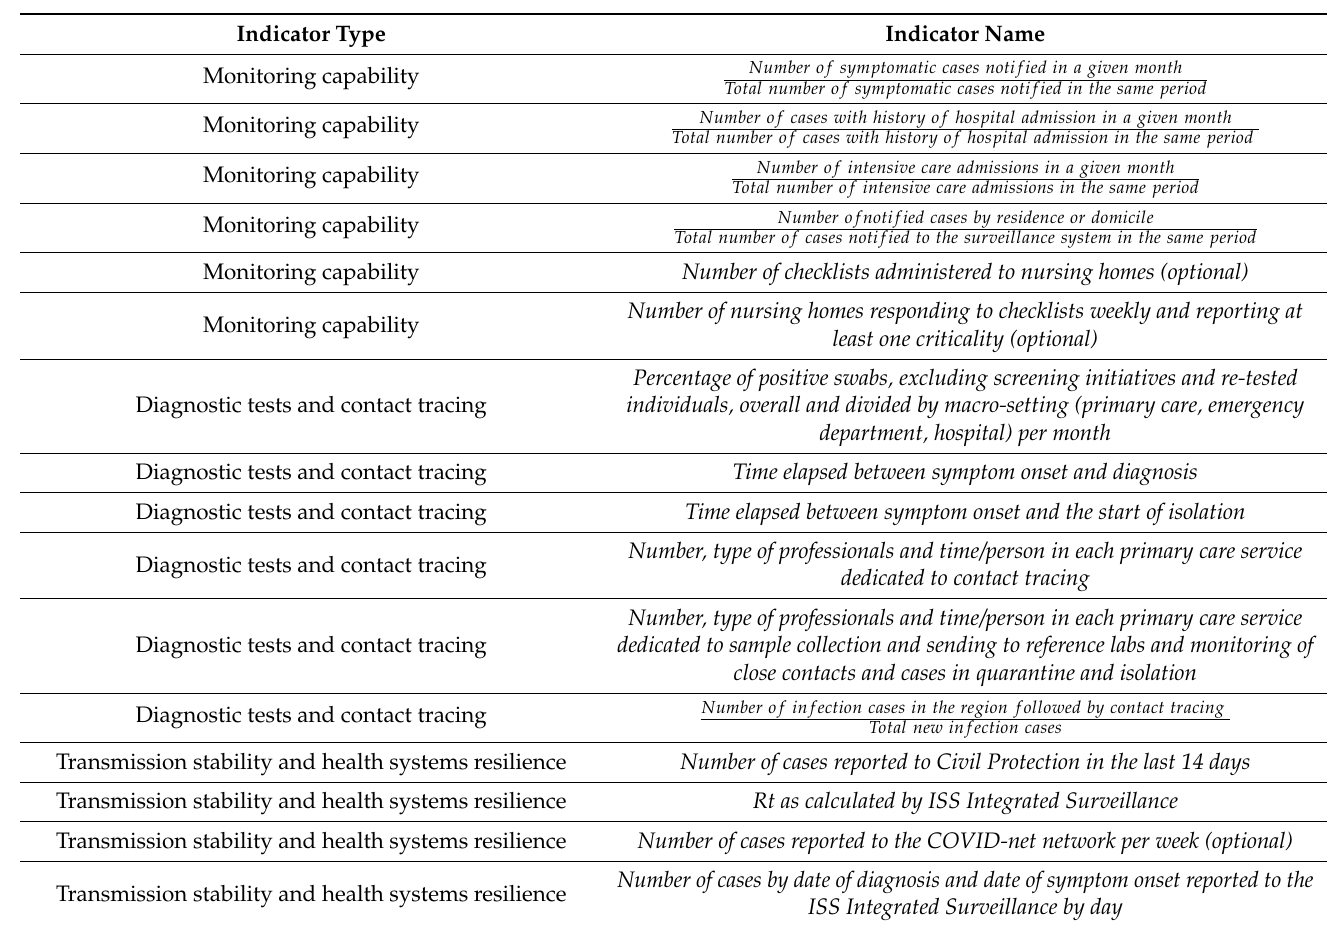
Table A1. 21 epidemiological indicators used to grade the impact of COVID-19 in Italian